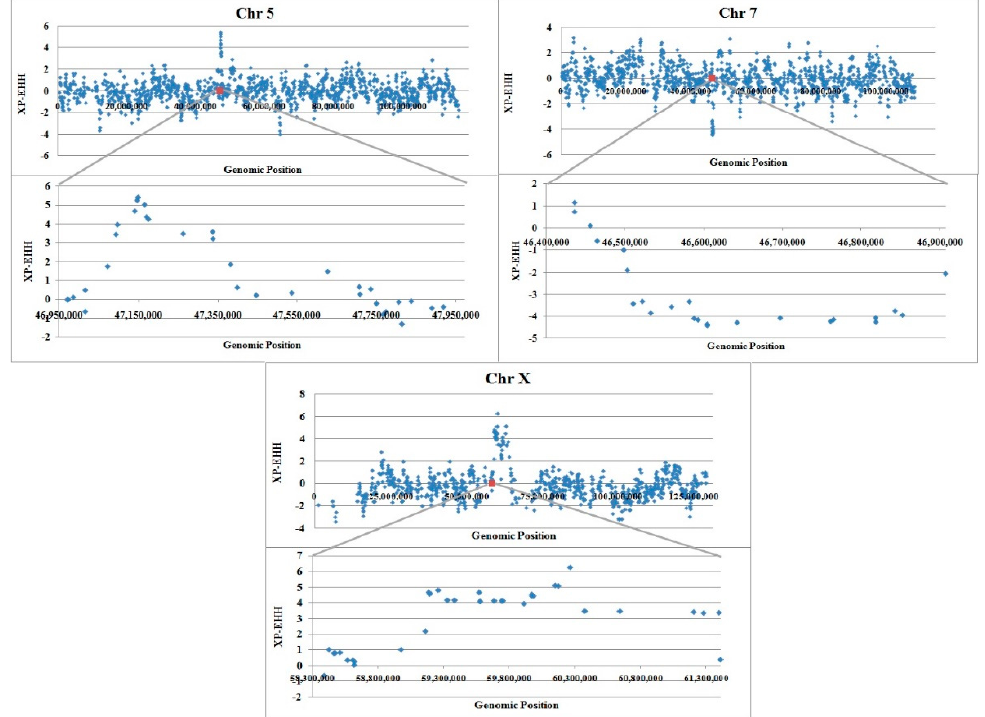
Figure 3. Plot of XP-EHH relation to genomic position (bp) for thin and fat tailed breeds on whole chromosome ( upper ) and our candidate region ( lower ) in different chromosomes: High positive values suggest selection in fat tailed population and negative values selection in thin tailed population. The genotyping information required for the presentation of the entire chromosomes were obtained from Moradi et al. [3]. Table 3. Core SNP alleles and haplotype frequencies in candidate regions for fat tail (Lori) and thin tail (Zel) breeds: The haplotypes with higher frequency in fat and thin tailed breeds have been